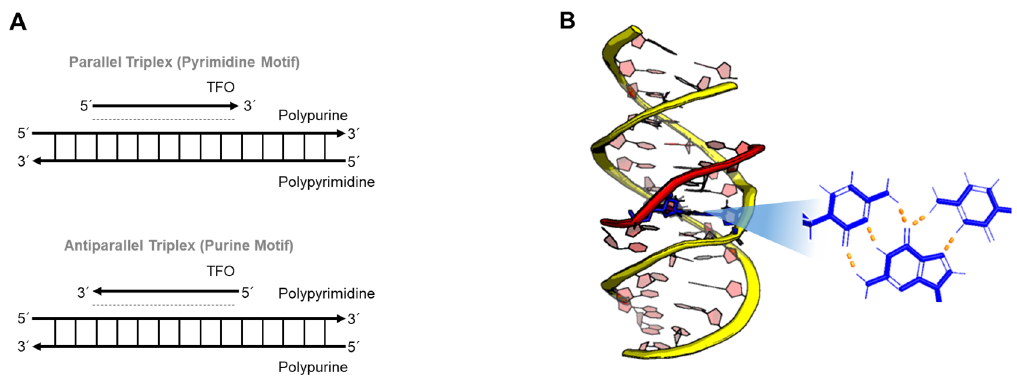
Figure 6. ( A ) Illustrations of parallel and antiparallel triple helices (TFO, triplex-forming oligonucleotide). ( B ) Side-view of a triple helix and base interactions at its midpoint (PDB id = 1BWG). The backbone of the TFO is shown in red. H-bonds between base-pairs are indicated by orange dashed lines.